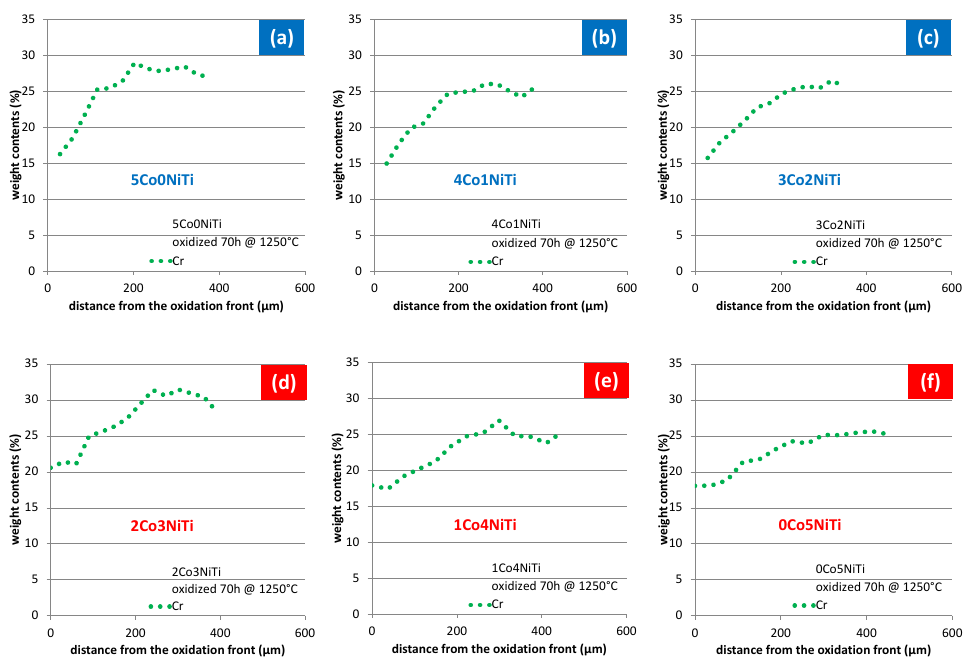
Figure 10. Concentration profiles for chromium acquired by EDS across the subsurface; ( a ): 5Co0NiTi, Figure 10. Cross-sectional observation of the external oxides and the subsurfaces affected by oxida- tion (Ni-richest alloys); white dotted arrows: line scans corresponding to the concentration profiles ( b ): 4Co1NiTi, ( c ): 3Co2NiTi, ( d ): 2Co3NiTi, ( e ): 1Co4NiTi, ( f ): 0Co5NiTi. presented in Figure 11; ( a ) and ( A ): 2Co3NiTi, ( b ) and ( B ): 1Co4NiTi, ( c ) and ( C ): 0Co5NiTi.